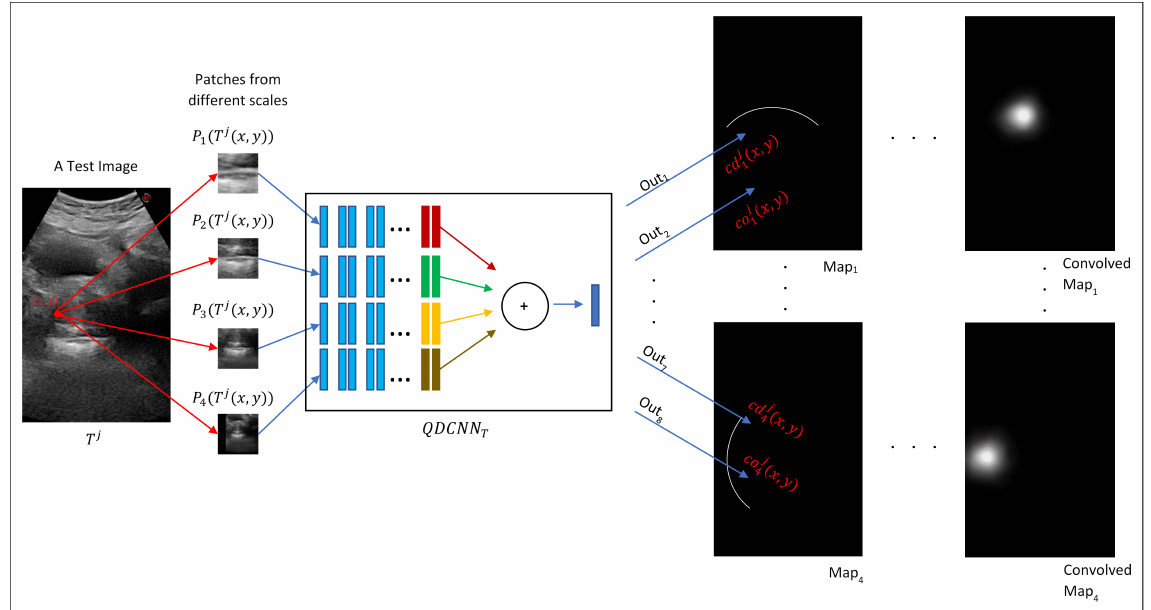
Figure 9. Creation of the voting maps for a given location T j ( x , y ) on a transverse image T j